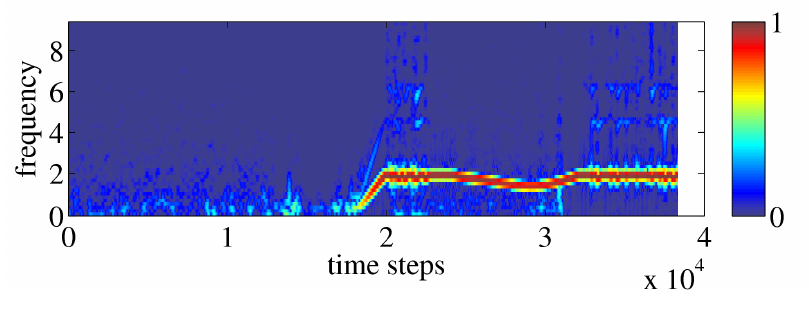
Figure 6. Power spectrum of the sensor value x (measured velocity) with a logarithmic 1 color scale during the experiment. Each column represents the lower frequency part of the discrete Fourier transform of a five second sliding window of the sensor value. Every time step a power spectrum is plotted. Blue pixels of the logarithmic color scale correspond to low energy and red to high energy in the corresponding frequency band. High energy in a certain frequency band means that changes between positive and negative velocity in the sensor value occur at about that frequency. The energy is normalized by the maximal energy in the power spectrum. In the beginning of the experiment no favorite frequency of behavior can be identified in the system. The start of the rotational mode of behavior is indicated by the appearance of the red line showing the frequency of rotation (around step 18000 ). During the rotational mode this frequency decreases due to a collision with a wall of the arena. After the collision the frequency increases again to the pre-collision value. The energy of the frequency of rotation is much larger as compared to the frequency components before this motion sets in. Hence the diagram shows only light blue dots before the rotational mode. The power spectrum of the sensor value x looks 2